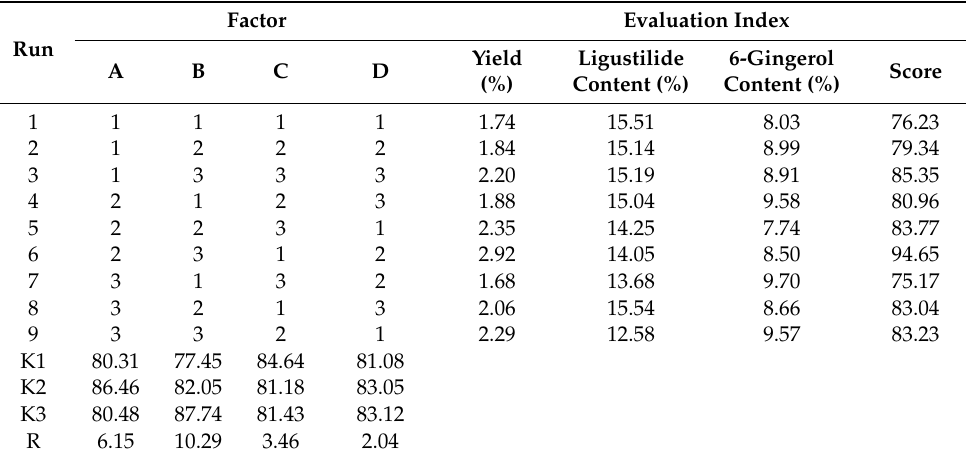
Table 2. Results of orthogonal experimental design for extraction optimization of AZ-SFE. A represented extraction pressure, B represented extraction temperature, C represented extraction time and D was blank.